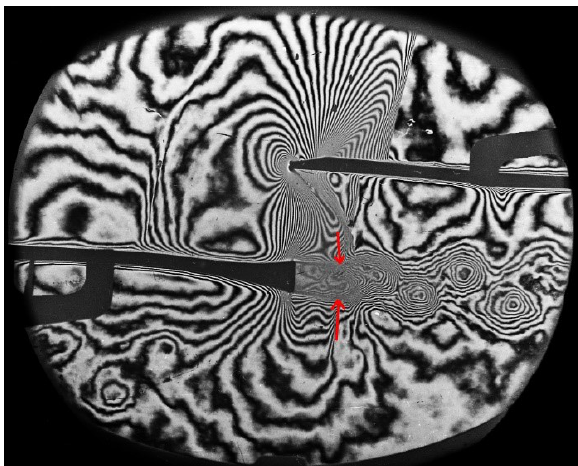
Figure 13. Tip section consisting of profiles with the tailored trailing edge, off-design condition of flow M 2 is = 0 . 912